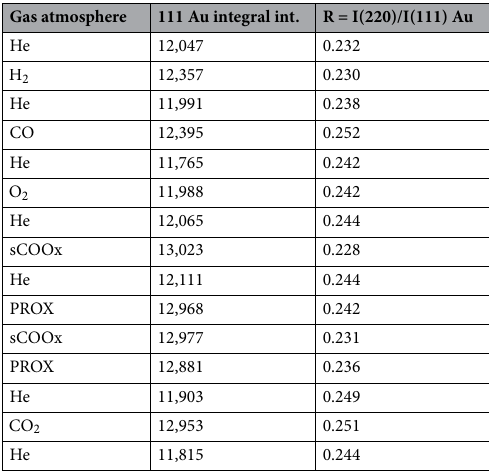
Gas atmosphere 111 Au integral int. R = I(220)/I(111)